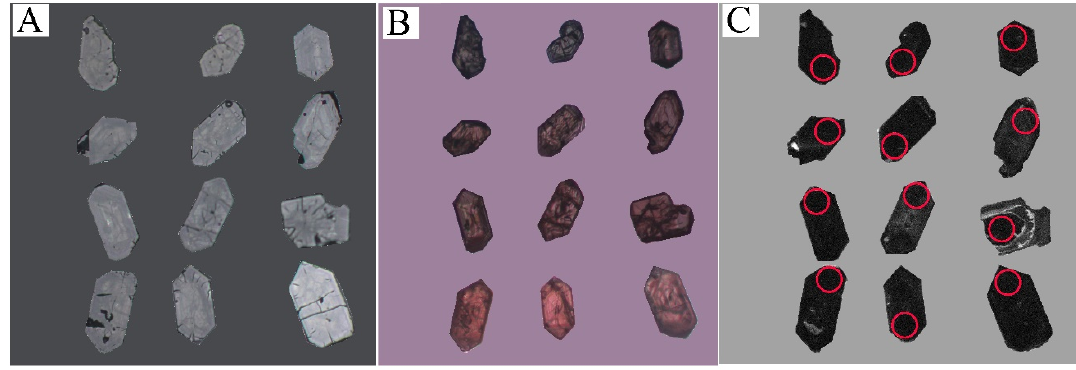
Figure 7. Petrographic characteristics of zircons from sample JSP030 and analyzed points. ( A ) Reflected light. ( B ) Transmitted light. ( C ) The cathodoluminescence image. Red circles indicate analysis points.